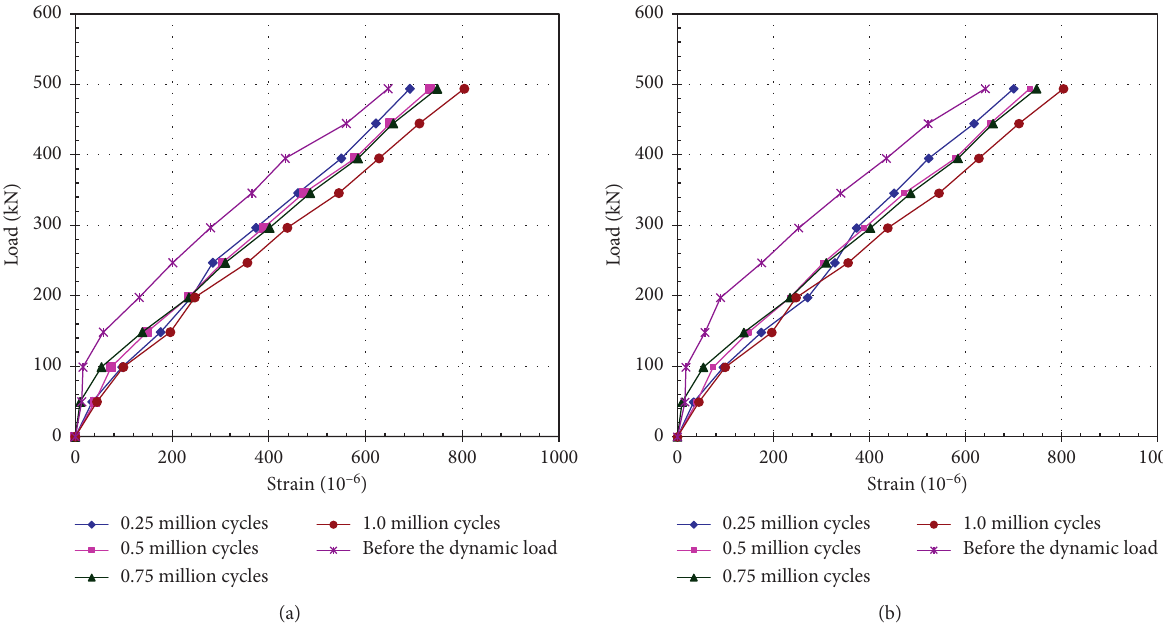
Figure 28: Curve of strain of PLG-1 steel beam with load. (a) Center line section. (b) 0.5 times the beam height section.